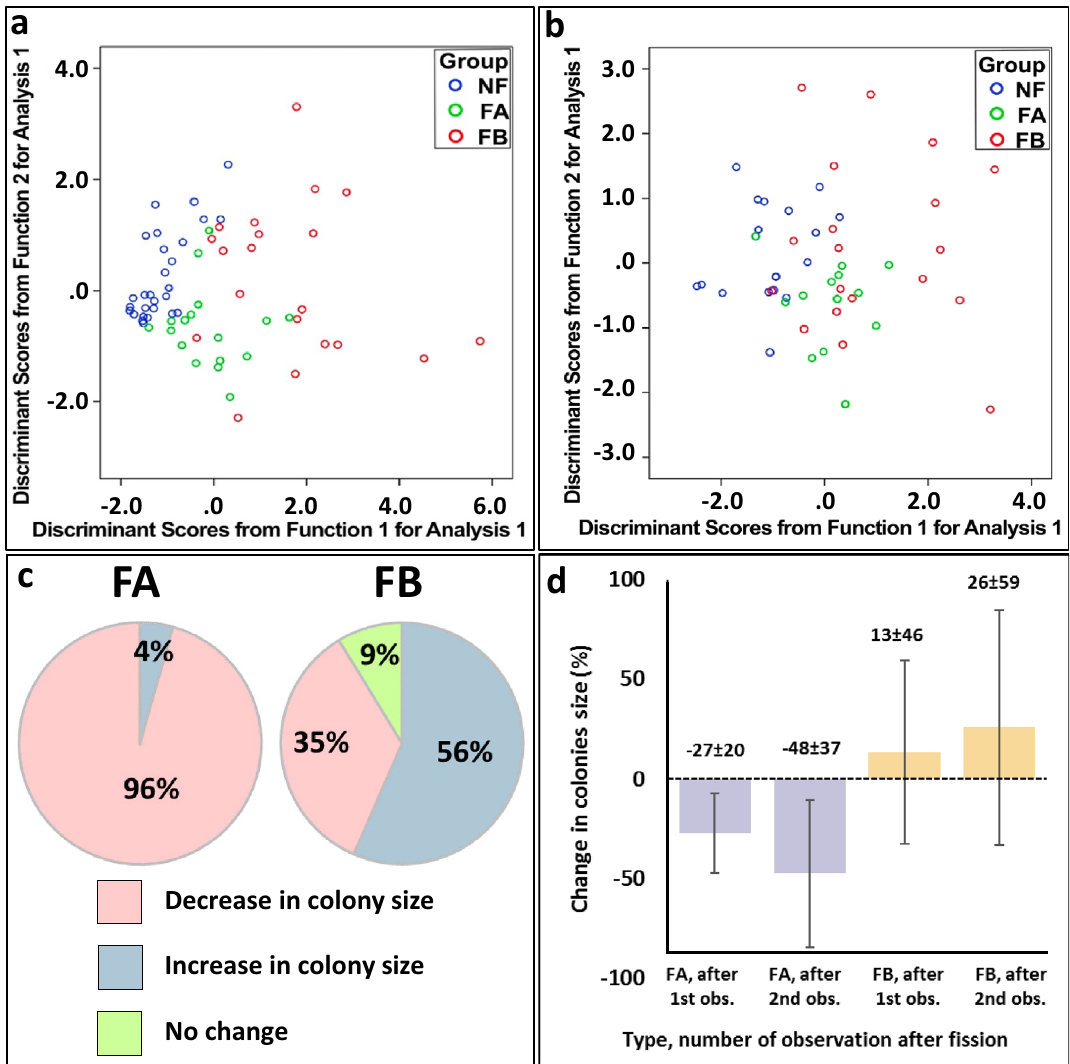
Figure 3. ( a , b ) Discriminant analyses outputs cluster the already assigned three life-history strategies of Botryllus colonies according to: ( a ) age at maximal colony size, life span, maximal size (number of zooids) and ages at the onset of male and female gonads (days). Colony numbers: NF = 28, FA = 17, FB = 20. ( b ) number of segments throughout the life, length of segments (days), number of times in a segment in which the